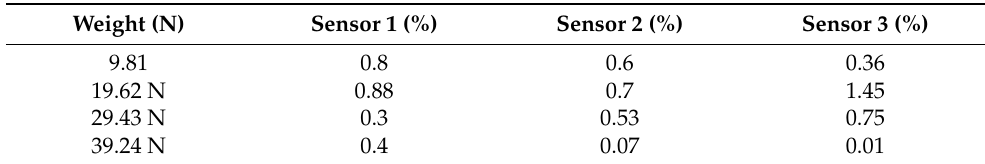
Figure 5. Sensor response (blue line) to sinusoidal input (red line) at ( a ) 1 Hz, ( b ) 3 Hz, ( c ) 6 Hz and ( d ) 12 Hz. The red line shows the input and the blue line shows the sensor response. Table 1. Percentage drift over 1 min constant loading. Weight (N)